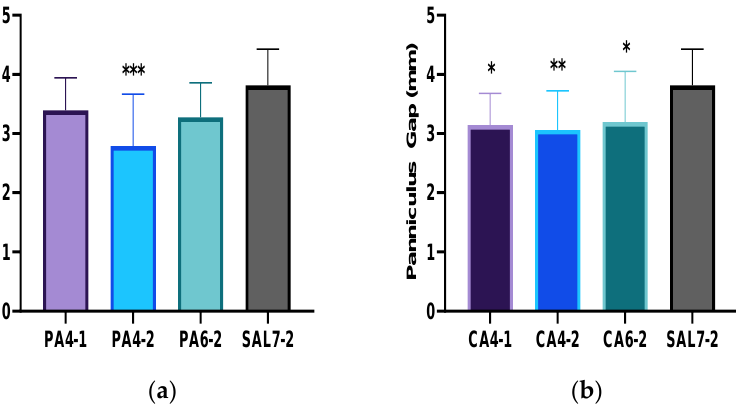
Figure 4. Panniculus carnosus muscle gap measurement during wound healing process when treated with ( a ) phosphoric acid (PA) buffered solutions of pH 4 and pH 6, ( b ) citric acid (CA) buffered solutions of pH 4 and pH 6 in comparison to saline control group (SAL7-2). Each bar represents mean ± standard deviation. * p <0.05, ** p <0.01 and *** p < 0.001 indicates the results obtained were statistically significant from control group (SAL7-2).